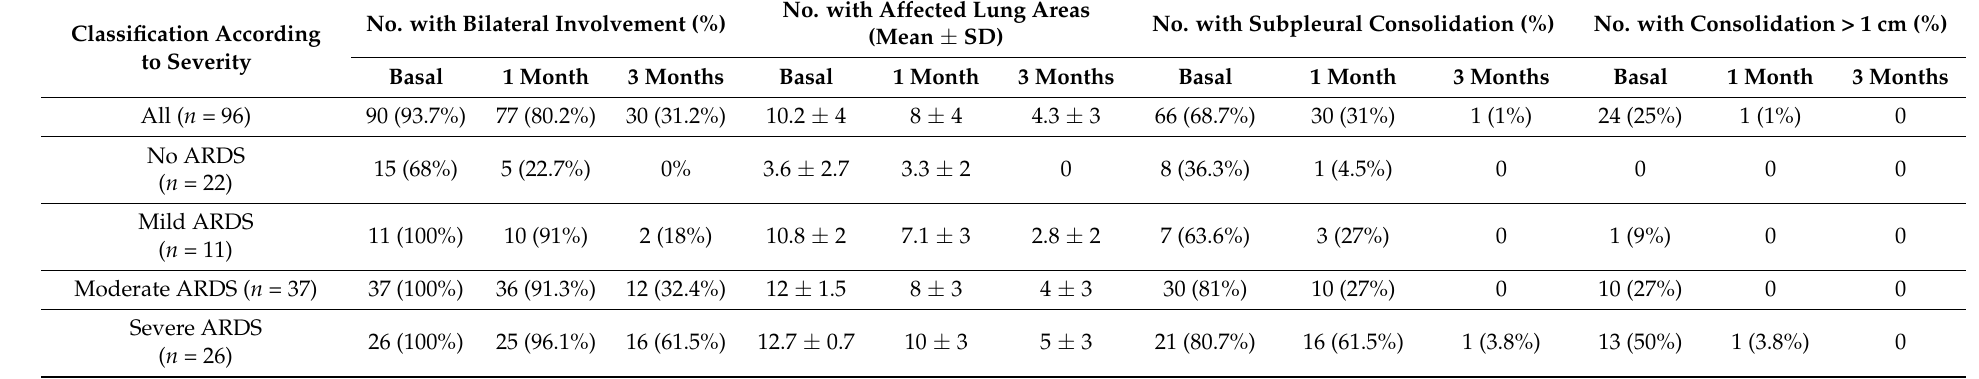
Table 2. Lung ultrasound findings at admission, one month and three months after